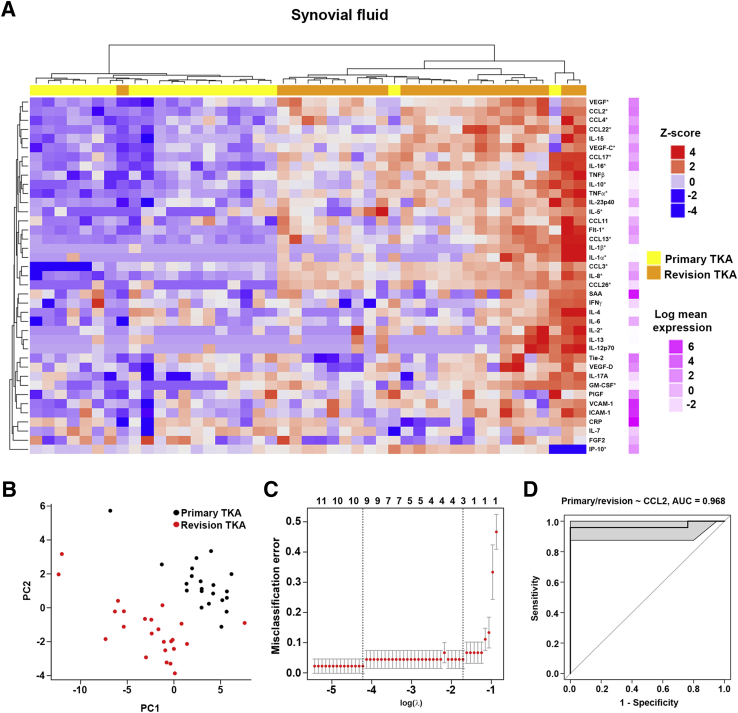
CCL2 in synovial fluid can be used to stratify patients undergoing revision total knee arthroplasty (TKA) from patients undergoing primary TKA. A: Heat map of log-transformed protein intensity in synovial fluid isolated from patients undergoing primary or revision TKA clustered using the differentially expressed markers with the highest fold change. Asterisks indicate markers that were used for clustering analysis/stratification. B: Principal component analysis plot of all patients using all markers. C: Classification error as function of the number of markers included, cross validated using glmnet package. Dotted lines mark two important values of the regularization parameter λ, which controls the number of markers included. On the left is the value of λ that gives the minimum mean cross-validated error. On the right is the value that gives the most regularized model, such that error is within one SEM of the minimum. D: Receiver operating characteristic curve for classification with CCL2 alone [area under the curve (AUC), 0.968; 95% CI, 0.89–1.0]. CRP, C-reactive protein; FGF, fibroblast growth factor; Flt, Fms-like tyrosine kinase 1; GM-CSF, granulocyte-macrophage colony-stimulating factor; ICAM, intercellular adhesion molecule; IFN, interferon; IP-10, interferon gamma-induced protein 10; PIGF, placental growth factor; SAA, serum amyloid A; Tie, tyrosine kinase; TNF, tumor necrosis factor; VCAM, vascular cell adhesion molecule; VEGF, vascular endothelial growth factor.